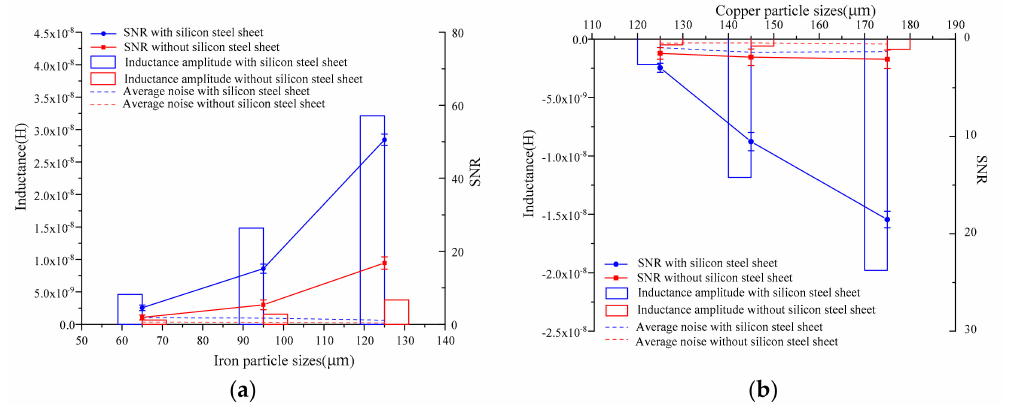
Figure 6. Comparative experimental results of iron particles and copper particles of di ff erent sizes: ( a ) iron particle detection comparative results ranging from 60 to 70 µ m, 90 to 100 µ m, and 120 to 130 µ m; ( b ) copper particle detection comparative results ranging from 120 to 130 µ m, 130 to 140 µ m, and 170 to 180 µ m. SNR = signal-to-noise